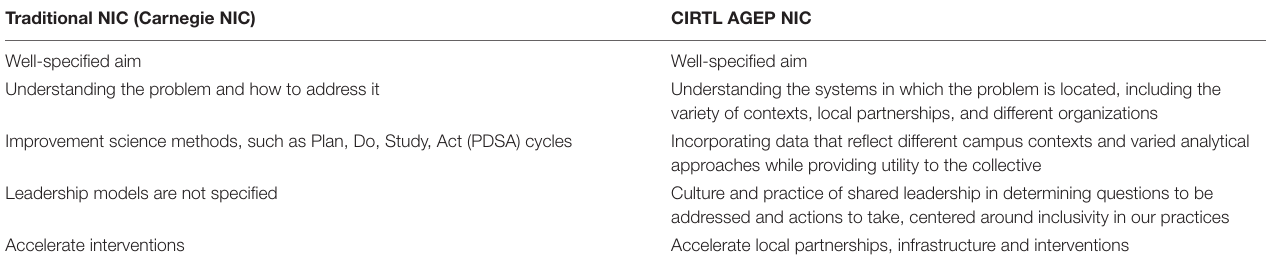
TABLE 1 | A comparison between the principles of a traditional (Carnegie) NIC and our CIRTL AGEP NIC. Traditional NIC (Carnegie NIC)